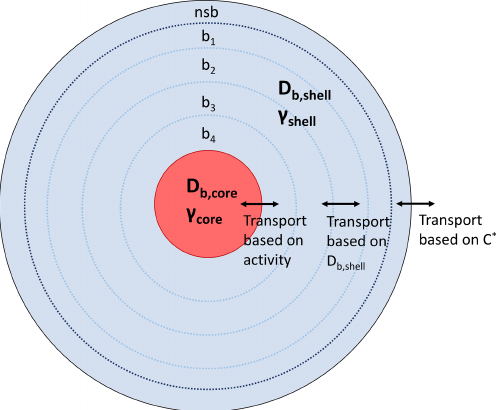
Figure 1. KM-GAP model representation showing the different particle layers with a near-surface bulk layer (nsb) and four ad- ditional bulk layers (b 1 –b 4 ). In this work D b , core = 10 − 8 and γ core = 1 for all runs, while D b , shell is varied between 10 − 5 to 10 − 20 cm 2 s − 1 and γ shell is varied in the range 10 − 3 to 10 5